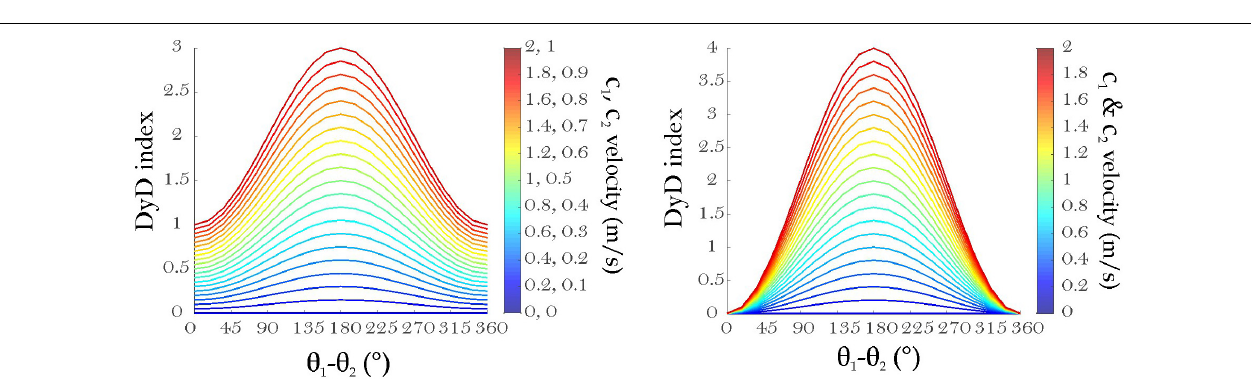
FIGURE 11 | Examples of Dynamic diversion index ( DyD ) for different values of c 1 and c 2 where θ 1 > θ 2 and c 2 = 1 / 2 c 1 , plotted over a full range of directions (left), and the DyD where c 1 = c 2